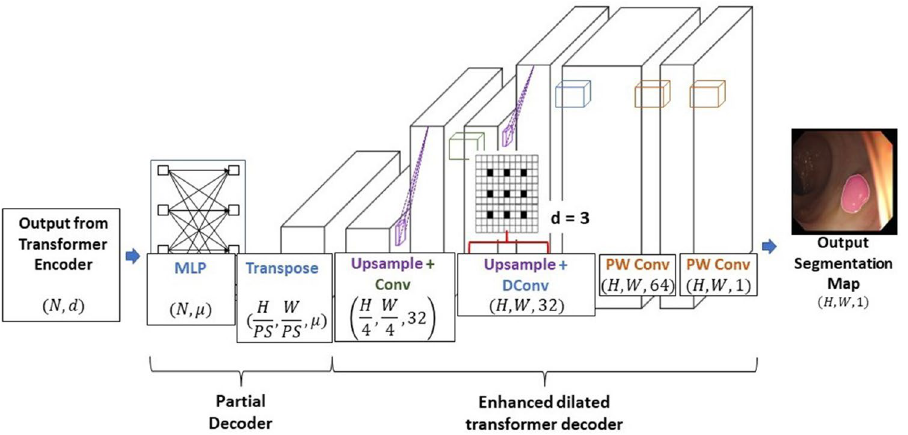
Figure 5. Details of the partial decoder and proposed enhanced dilated transformer